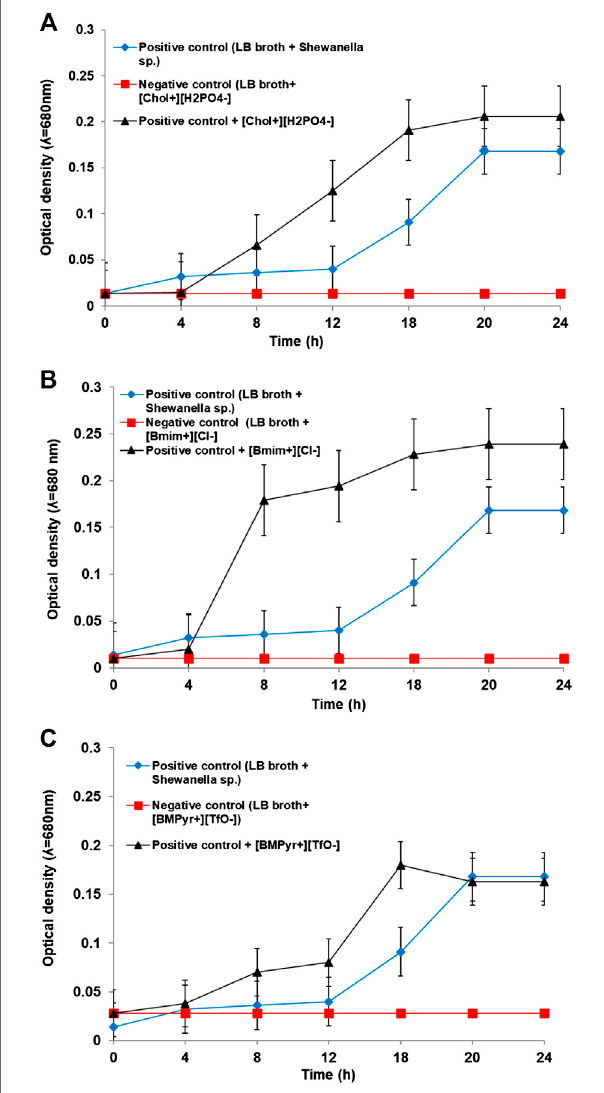
FIGURE2|(A) Growthpro fi leof Shewanella sp.inLBbroth.( ■ )Negative control(LB+[Chol + ][H 2 PO 4 − ] 2%v/v).( ◆ )PositivecontrolLB+ Shewanella sp. ( ▲ ) Positive control + [Chol + ][H 2 PO 4 − ]. (B) Growth pro fi le of Shewanella sp. in LB broth. ( ■ ) Negative control (LB+ [Bmim + ][Cl − ] 2%v/v). ( ◆ ) Positive control LB + Shewanella sp. ( ▲ ) Positive control + [Bmim + ][Cl − ]. (C) Growth pro fi leof Shewanella sp.inLBbroth.( ■ )Negativecontrol(LB+[BMPyr + ][TFO − ] 2%v/v). ( ◆ ) Positive control LB + Shewanella sp. ( ▲ ) Positive control +[BMPyr + ][TFO −